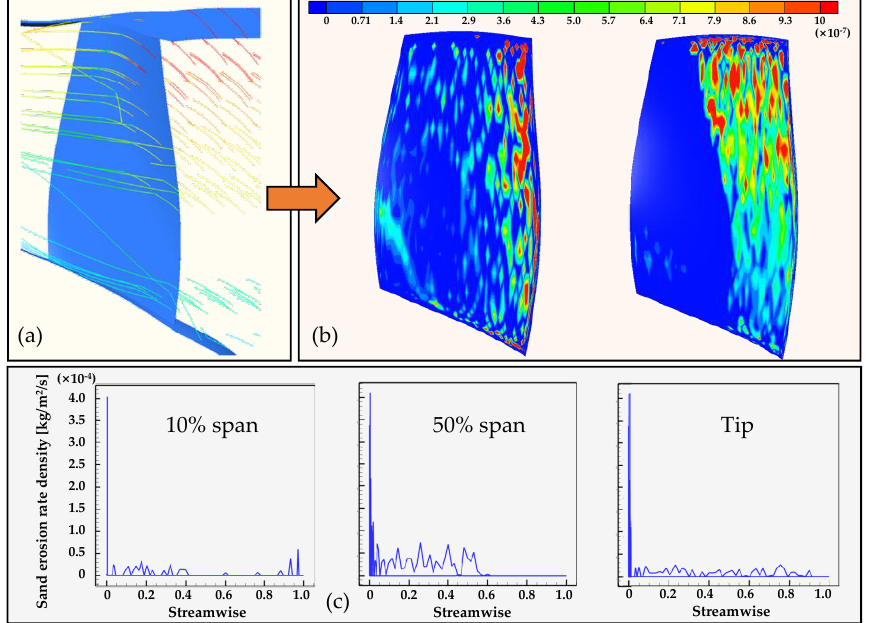
Figure 7. Particle erosion of fan rotor blades: ( a ) Trajectory of particles; ( b ) erosion rate cloud map of the pressure side; and ( c ) the erosion rate distribution curves at different spans.